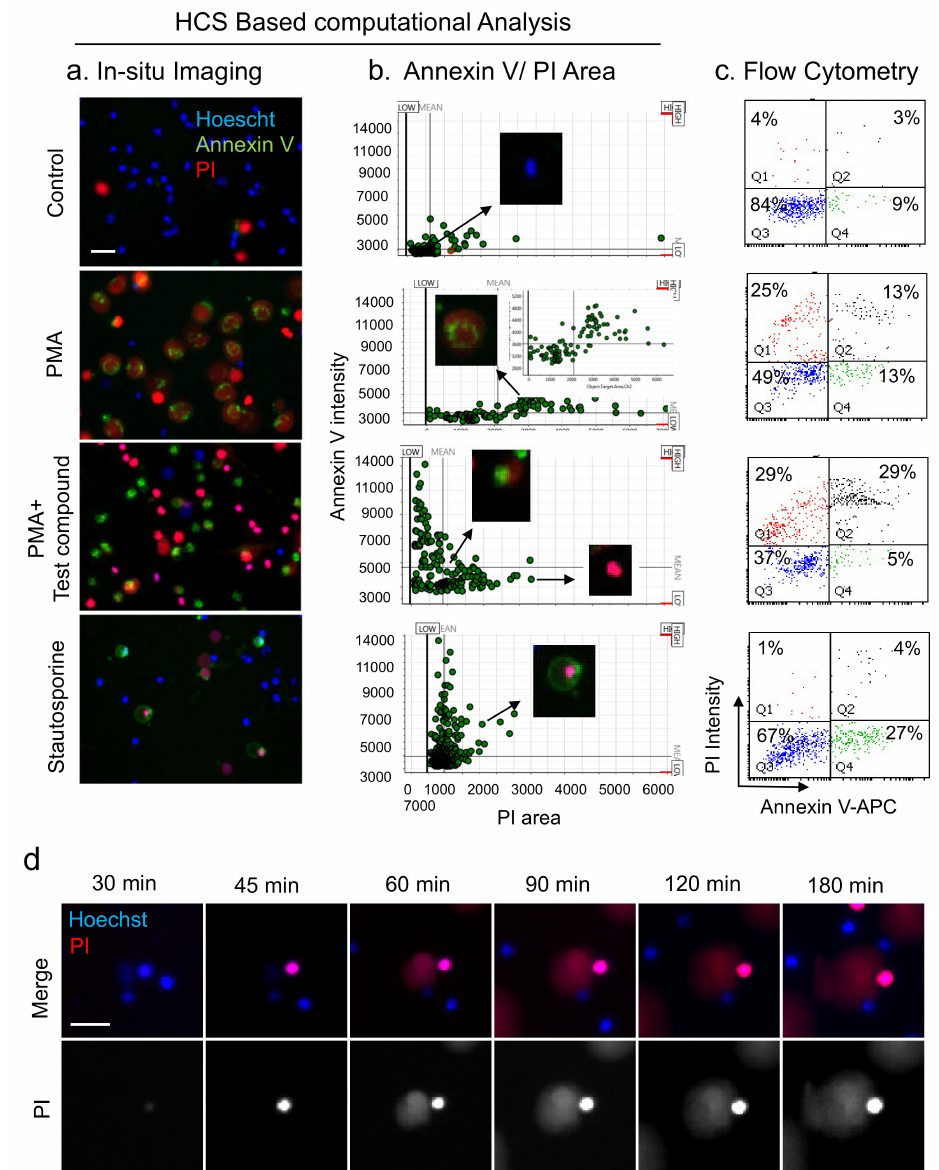
Figure 5. HCS-Cellomics and flow-cytometry-based analyses of NETs, apoptosis, and necrosis. ( a ) Representative image of Annexin V, PI, and Hoescht positive cells in different treatment groups. Cells were treated with 10 µ M tested compound, 100 nM PMA, or 1 µ M staurosporine for 3 h